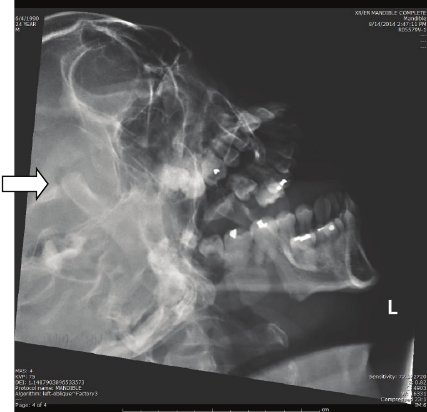
Figure 1: X-ray mandible series (left lateral view). The arrow is pointing to the condylar head.